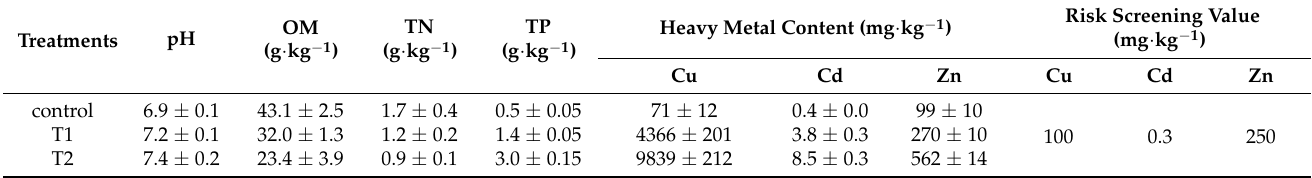
Table 1. Characteristics of the control, T1 (mixture of clean and polluted soil, 50%), and T2 (100% polluted soil) treatment